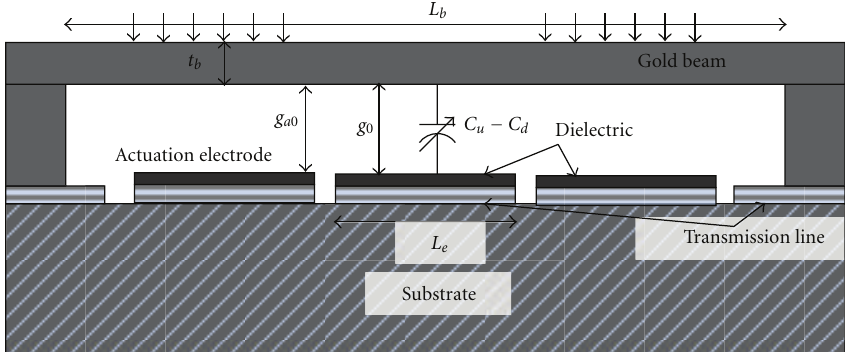
Figure 1: Side view of a traditional parallel plate capacitive switch in CPW configuration with separate actuation electrodes.